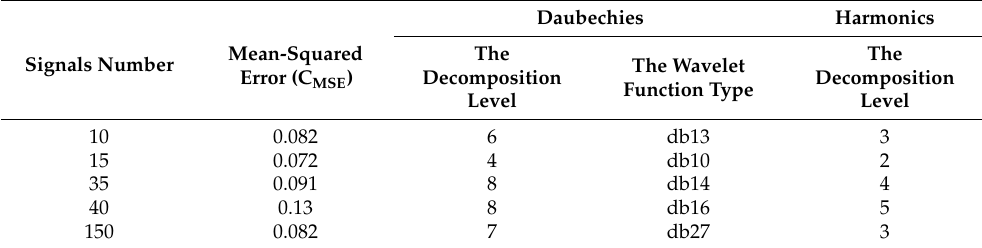
Table 1. C MSE evaluation criterion performance comparison.